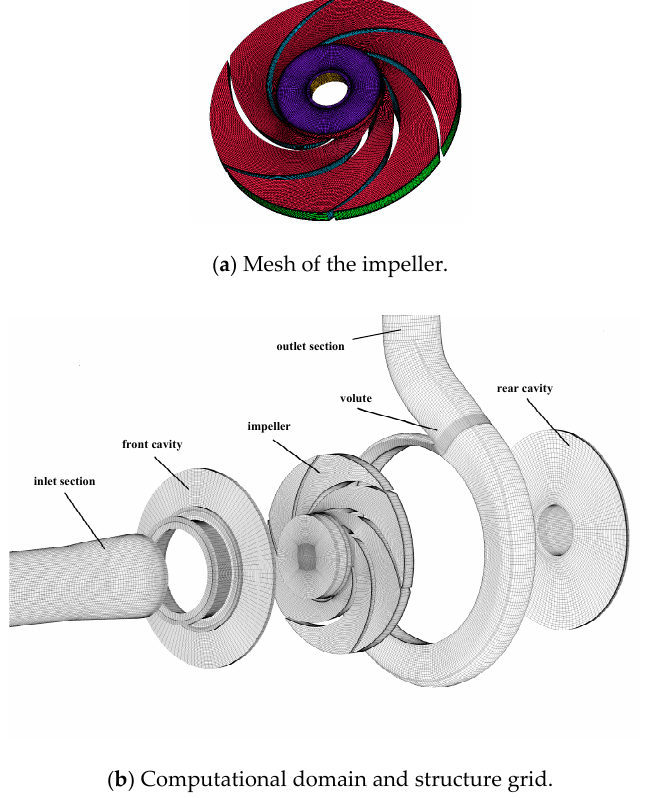
( b ) Computational domain and structure grid. Figure 2. Mesh of the pump. Figure 2. Mesh of the Figure 2. Mesh of the pump.